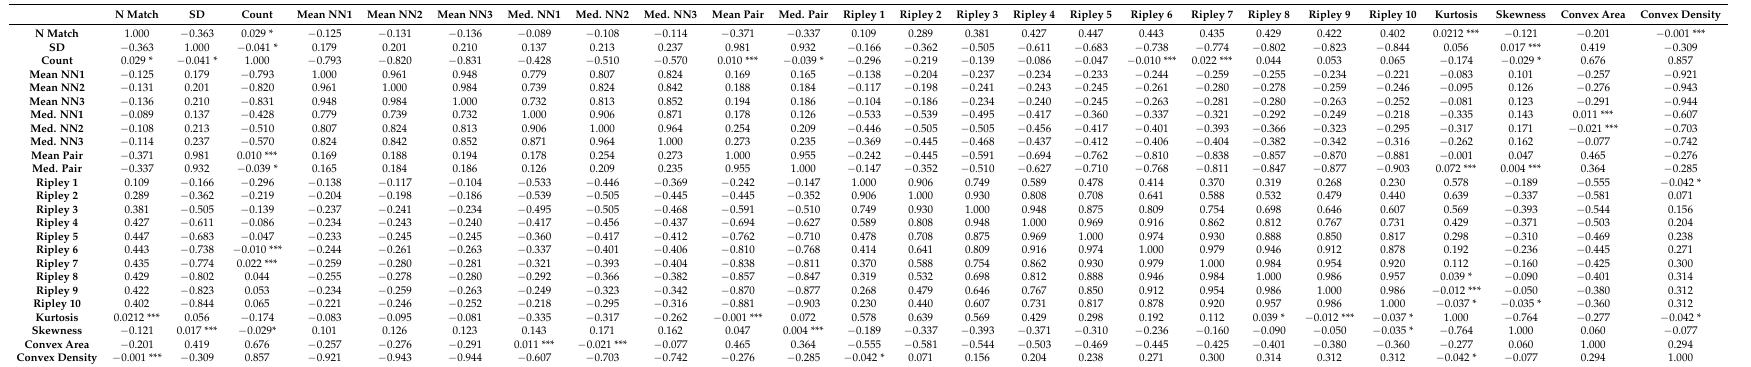
Table A1. Pearson’s correlation matrix for all predictive spatial statistics measures. * indicates p < 0.1; *** indicates no significance; and all other values are significant to p <